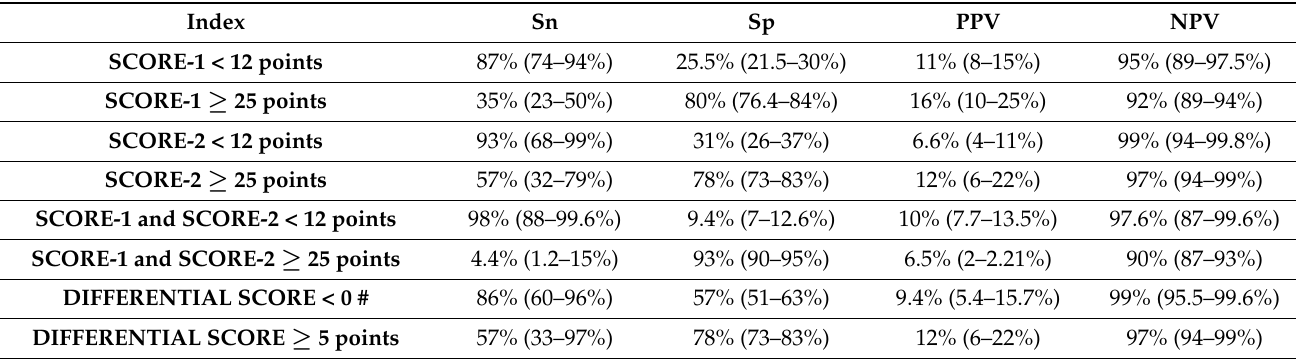
Table 3. Comparison of sensitivity, specificity, positive predictive value, and negative predictive values, in the detecting of the endpoint (orotracheal intubation or death), between two point-of-care ultrasonographic scores. For each score and their combinations, the values obtained for the lowest-highest risk-strata are detailed.